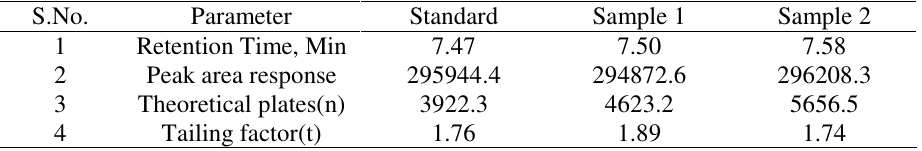
Table 1. Results of system suitability parameters of gemifloxacin mesylate in standard and in tablet